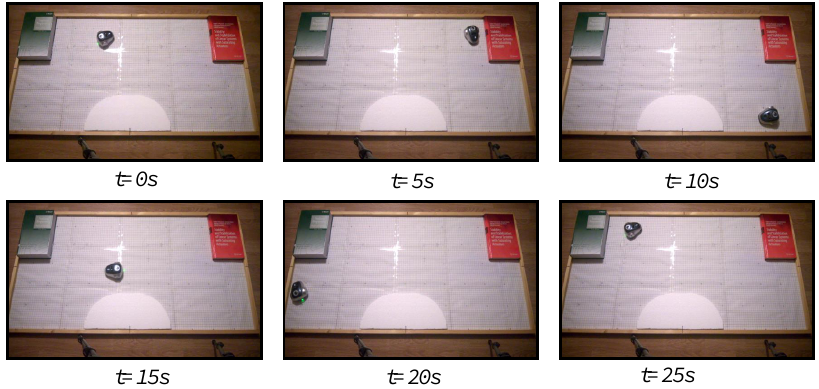
Figure 10. Experiment 1. Wall following algorithm using discrete-time architecture.